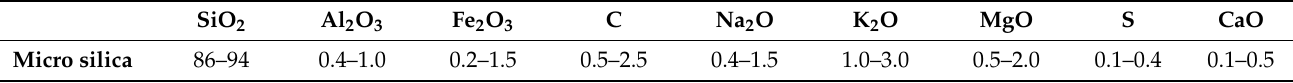
Table 2. Chemical analysis (wt.%) of micro-silica powder used in this